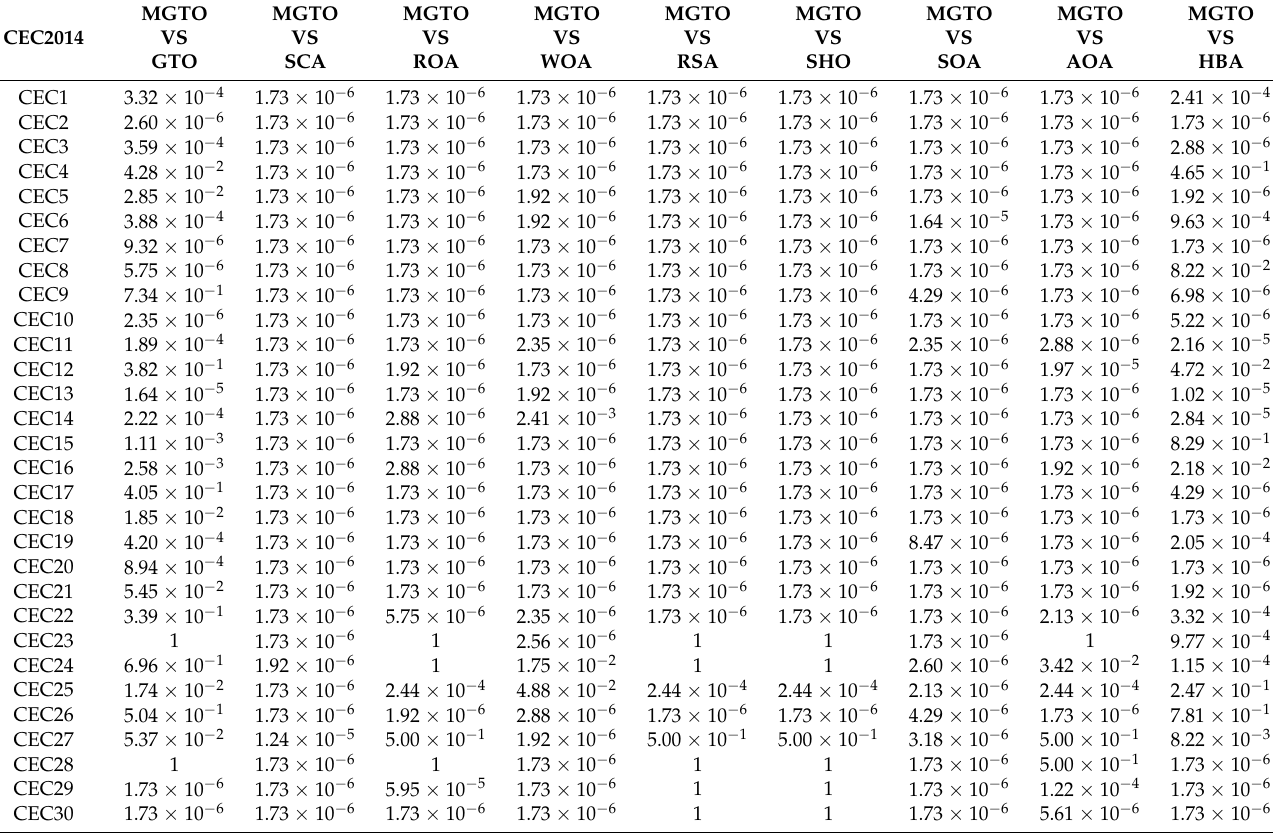
Table 7. CEC2014 Experimental Results of Wilcoxon Rank-Sum Test on Benchmark Functions.